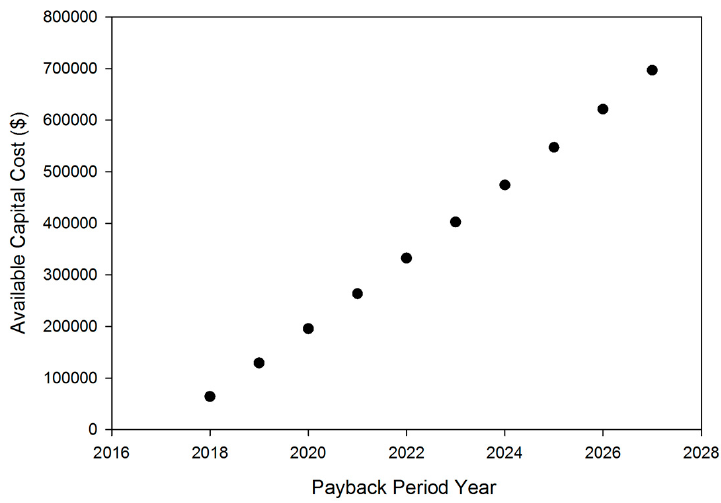
Figure 9. The ACC for a large office in Tucson, AZ.